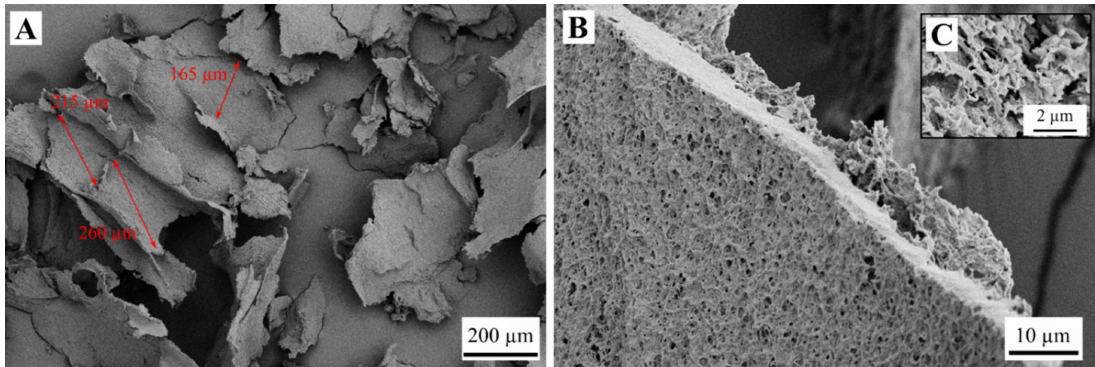
Figure 7. Structure of the sample FD-NG-LN derived from 5 wt.% starch suspension and freeze-dried at sublimation pressure of 0.045 mbar. Picture ( A ) shows an overview of the material structure and pictures ( B , C ) a pore wall with higher magnifications